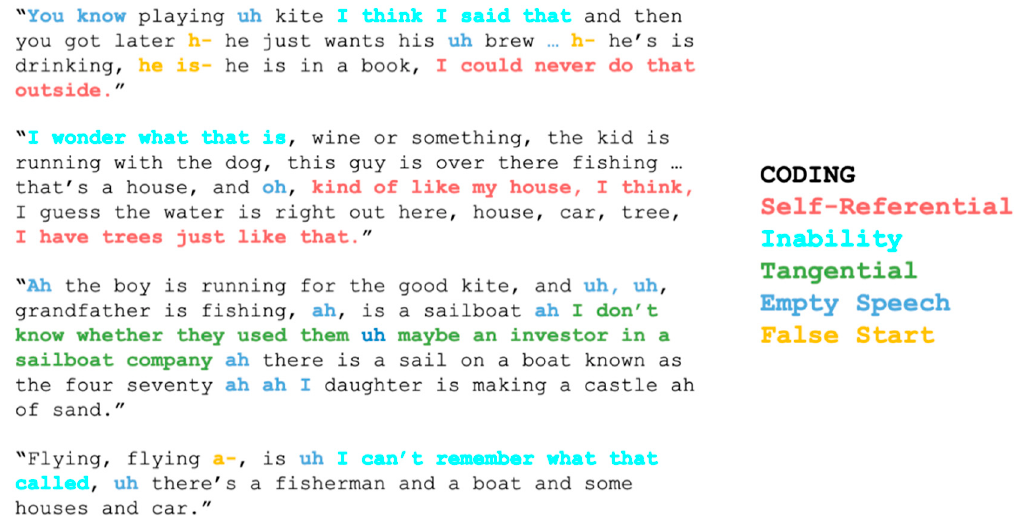
Figure 2. Examples of speech excerpts that were coded as self-referential, reflecting inability to decipher the picture or retrieve the right word, tangential, empty, or reflective of a false start.